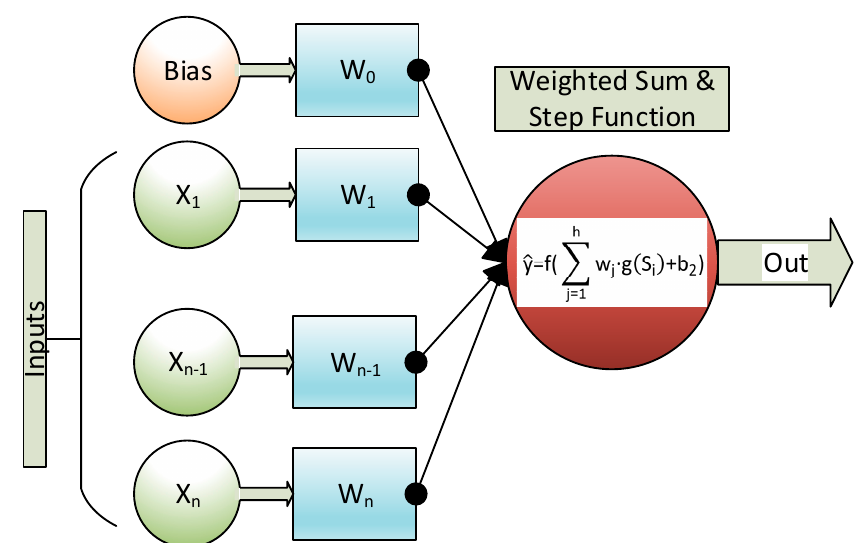
Figure 3. Scheme of a conventional multilayer perceptron.